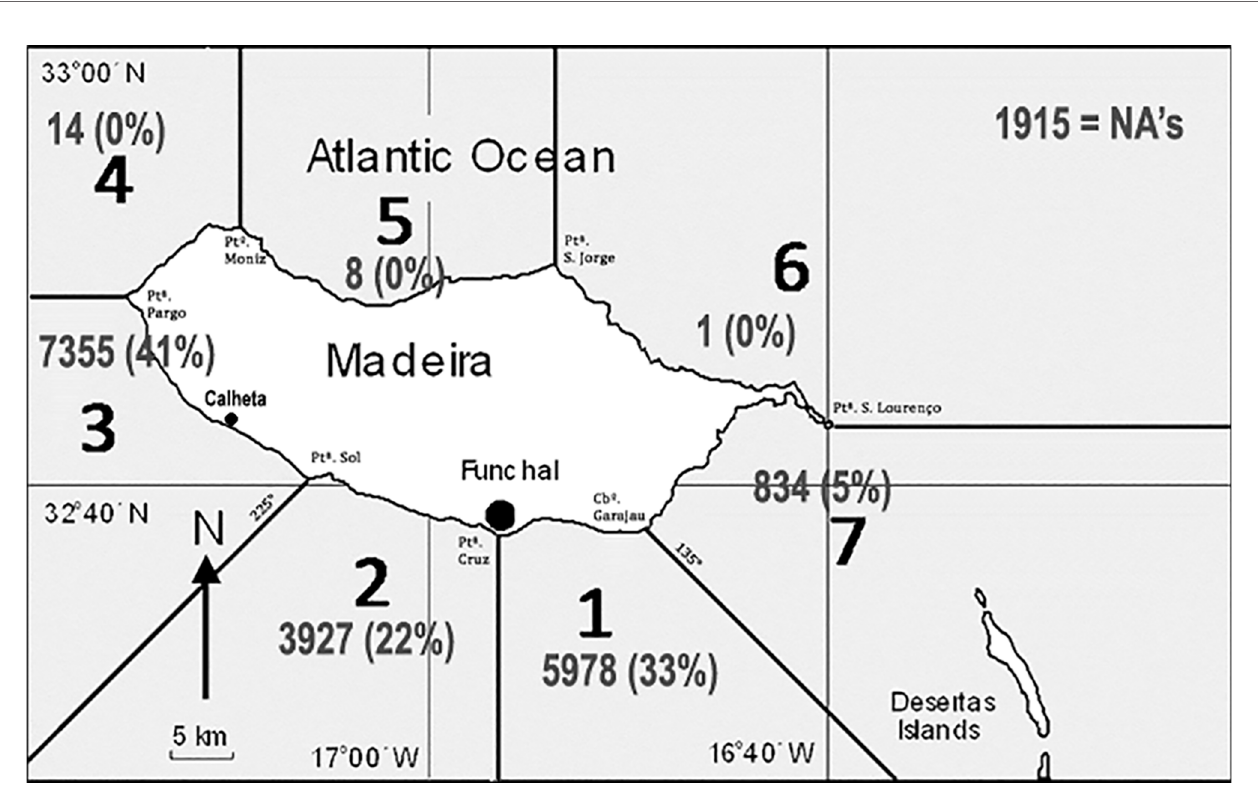
FIGURE 1 | Map of Madeira Island showing the divisions into counting sectors as well as the locations of the marinas of Funchal and Calheta. The numbers represent sampling effort in each sector as number of trips and percent of all trips (NA indicates trips with no recorded